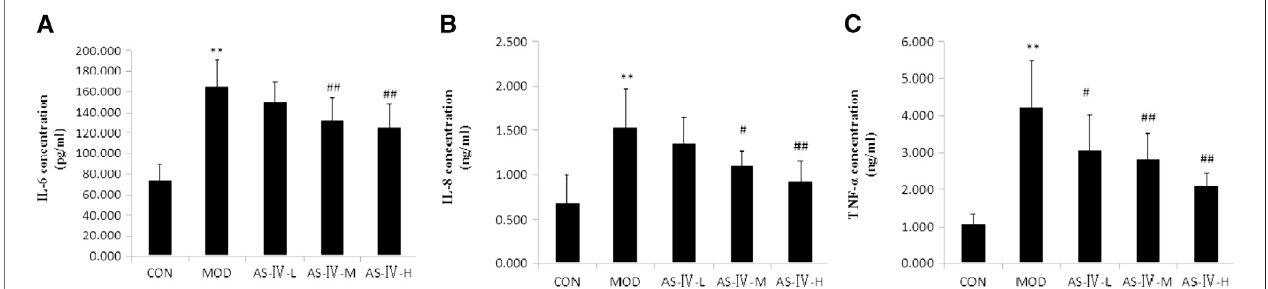
FIGURE 6 | Effects of astragaloside IV on in fl ammatory factors in NAFLD rats. (A) Serum IL-6 concentration. (B) Serum IL-8 concentration. (C) Serum TNF- α concentration. Data present the mean ± SD. Comparisons between two groups use t -tests, and data comparison among multiple groups use one-way ANOVA. * p < 0.05 and ** p < 0.01 compared with the control group; # p < 0.05 and ## p < 0.01 compared with the model group. CON, control group; MOD, model group; AS-IV-L, astragaloside IV low-dose group; AS-IV-M, astragaloside IV middle-dose group; AS-IV-H, astragaloside IV high-dose